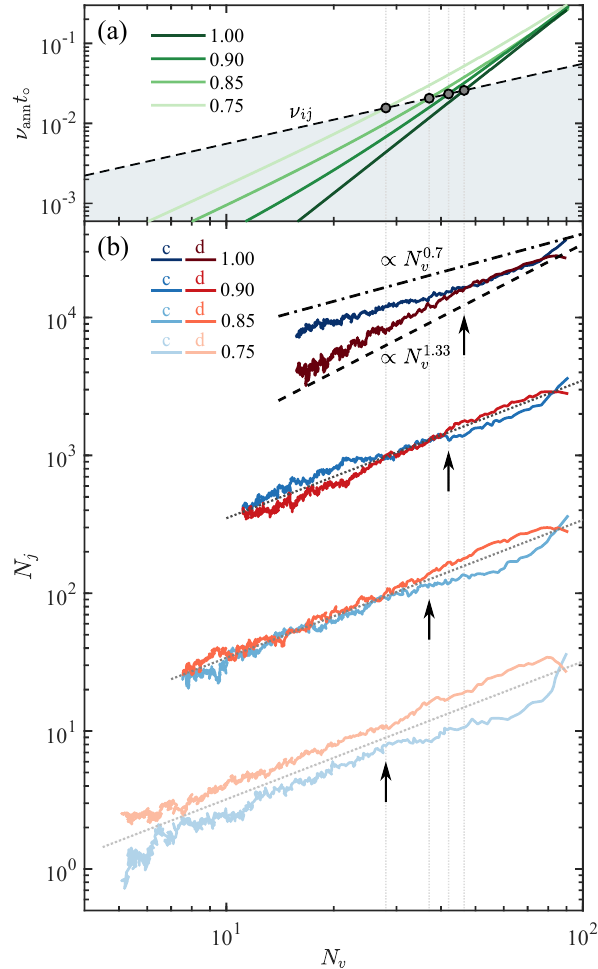
Figure 5: (a) The vortex annihilation rates ν for all four initial condensate tempera- ann tures (solid green lines) are compared to the rate ν of vortex reconfiguration (dashed ij line) as a function of the total vortex number. The shaded region indicates quasiequi- < ν librium, where ν , and the black dots denote the points at which this condition ij ann is first met for each condensate temperature. (b) The mean number of vortex clusters ( j = c , blue) and vortex dipoles ( j = d , red) as functions of total vortex number N v for each initial condensate temperature. For clarity, the curves are shifted vertically = { 0.75,0.85,0.90,1.00 } , by multiplying N by 10 n , where n = { 0,1,2,3 } for n j 0 = 1.00, the data compare well with N ∼ N 0.7 respectively. For n (dot–dashed line) c v 0 ∼ N 1.33 ∼ N and N (dashed line). For all other temperatures, N (dotted lines) d v j v yields a more reasonable comparison. The vertical dotted grey lines are traced from the quasiequilibration points identified in panel (a), and these points are highlighted on each appropriate N curve by vertical arrows. Note that time flows right to left in j this figure.